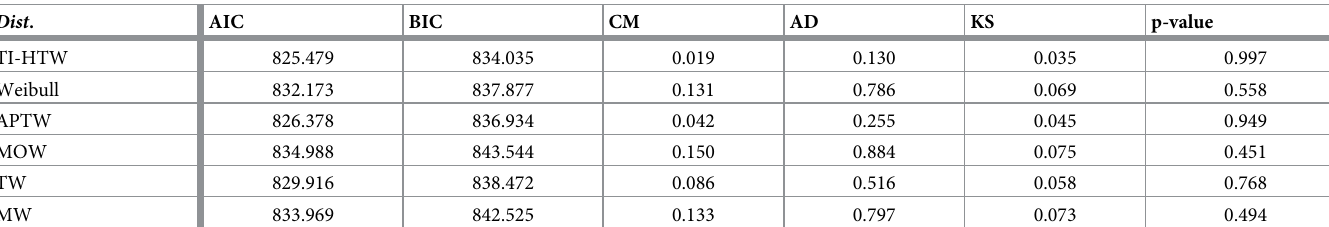
Table 8. Discrimination and goodness of fit measures of the TI-HTW and other competitive models for data 1. Dist .